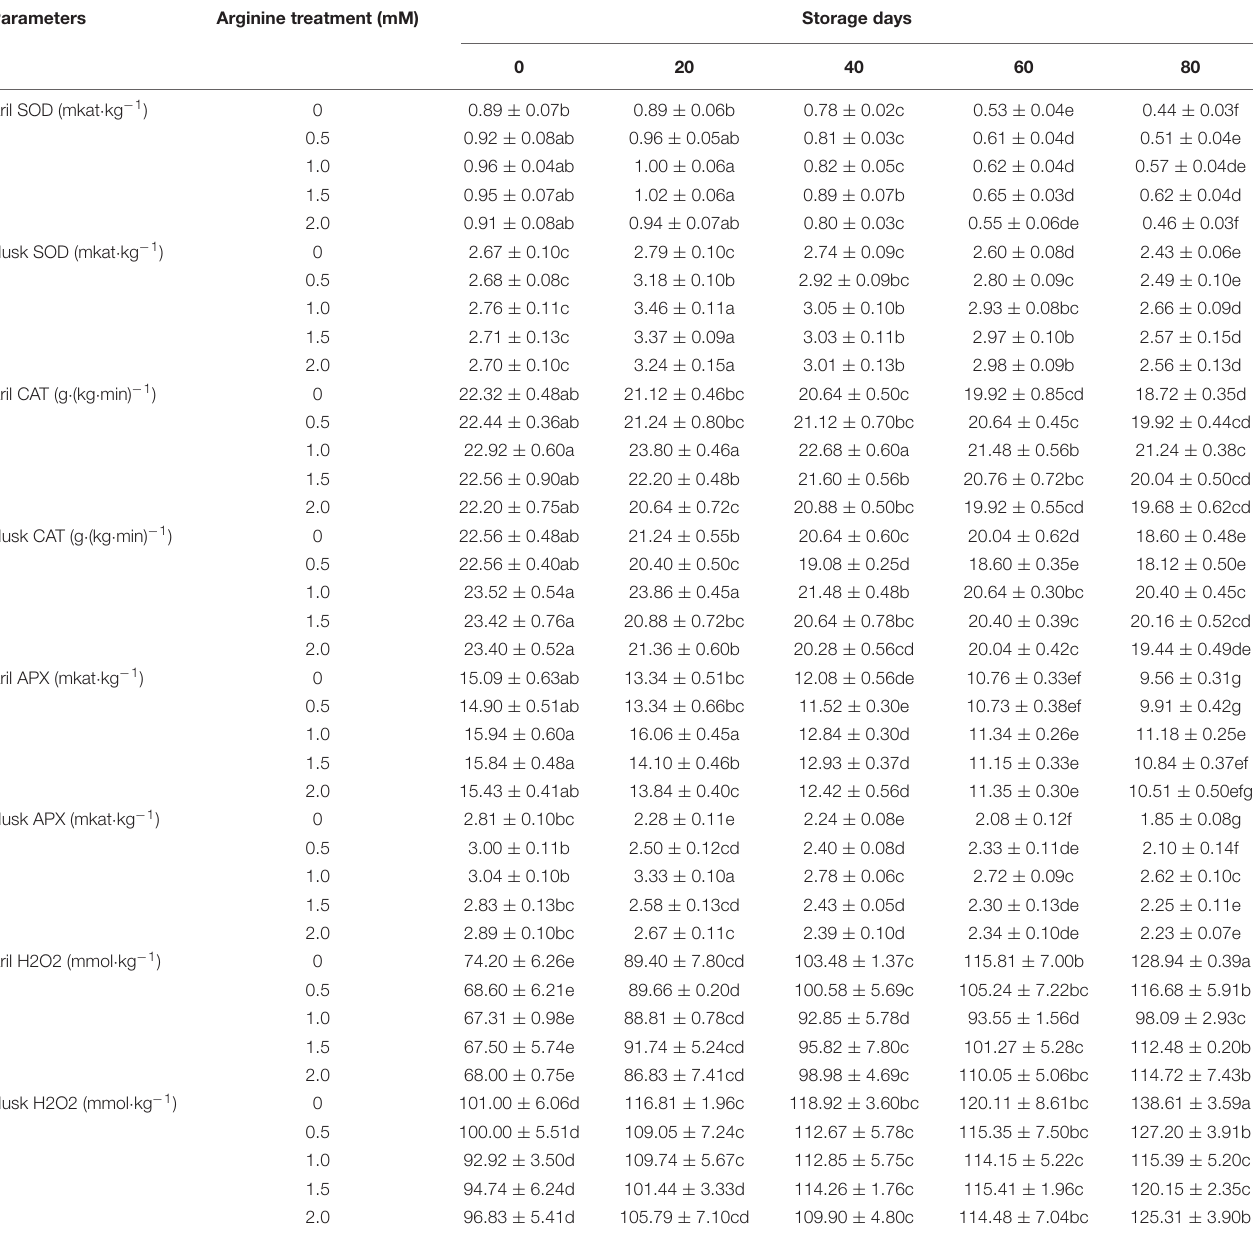
TABLE 2 | Enzyme activities of SOD, CAT, APX, and H 2 O 2 content in Yudazi husks and arils during cold storage at 4 ± 0.5 ◦ C.